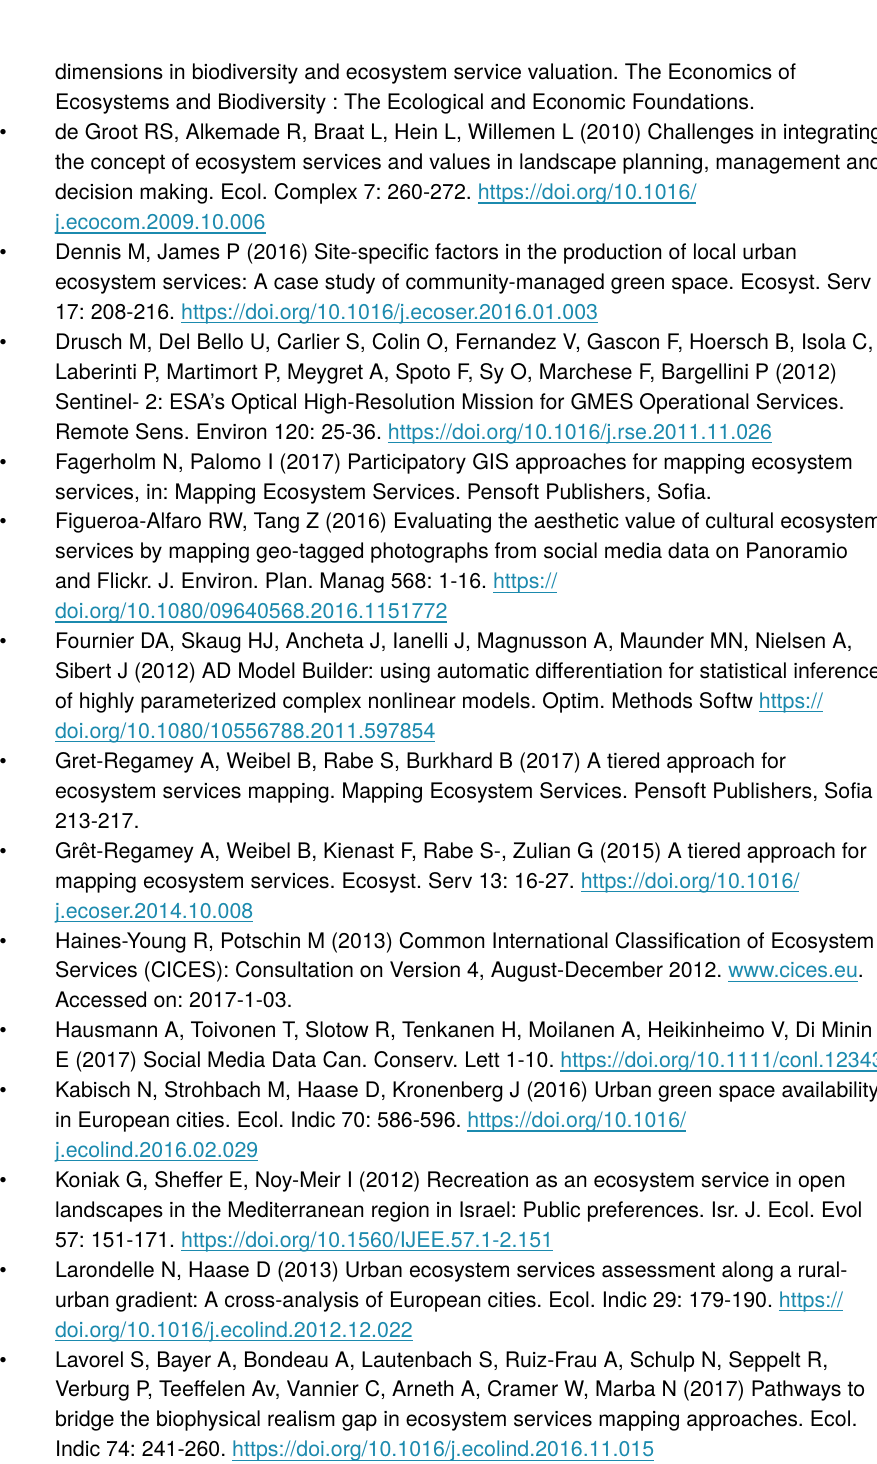
Figueroa-Alfaro RW, Tang Z (2016) Evaluating the aesthetic value of cultural ecosystem services by mapping geo-tagged photographs from social media data on